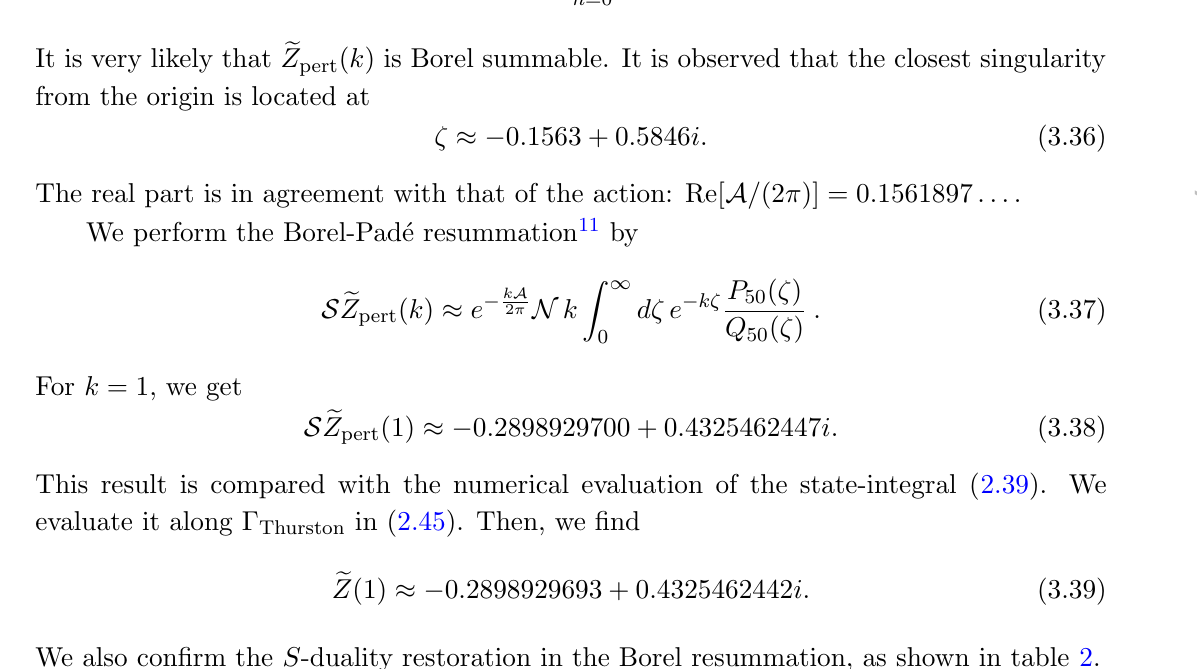
Figure 3 . The pole structure of Q n for n max = 50